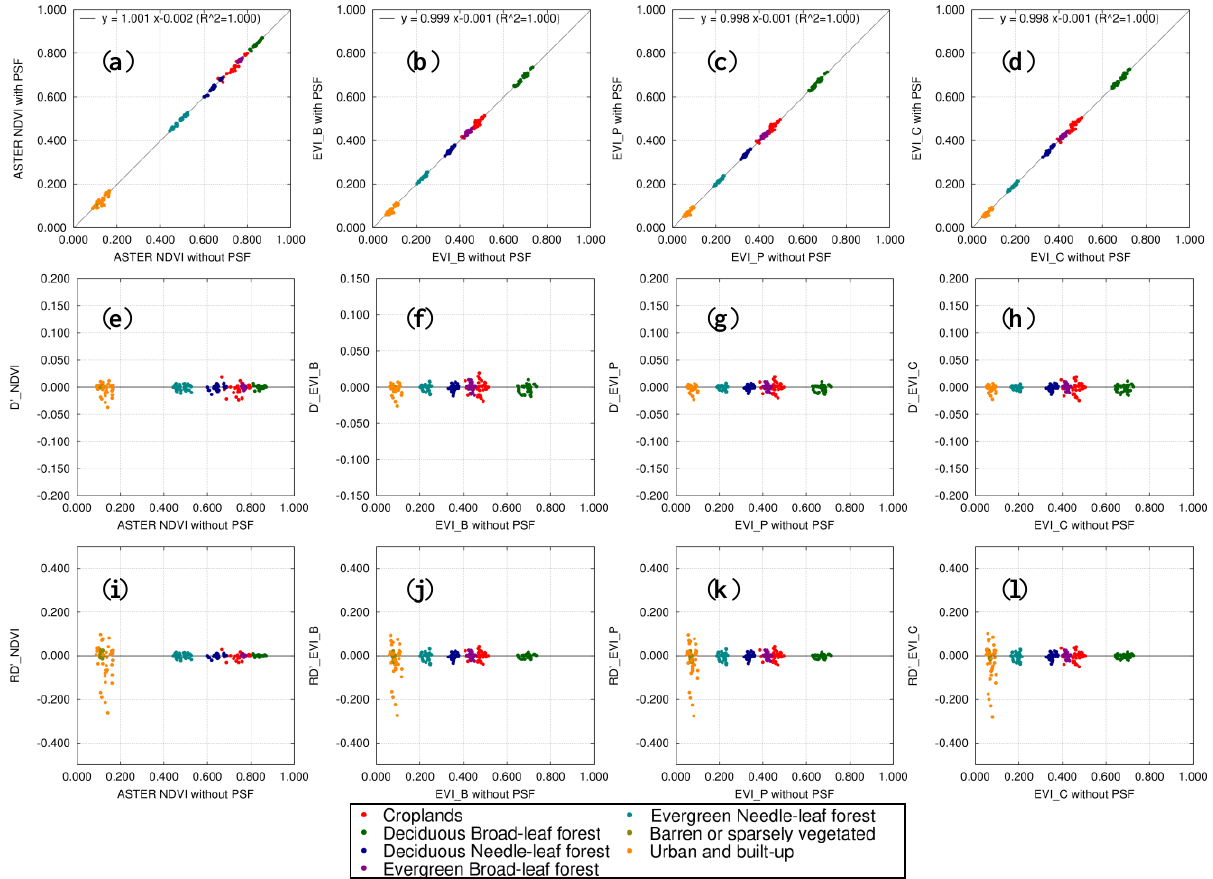
Figure 6. Scatterplots of ASTER NDVI and EVI aggregated with vs . without MODIS